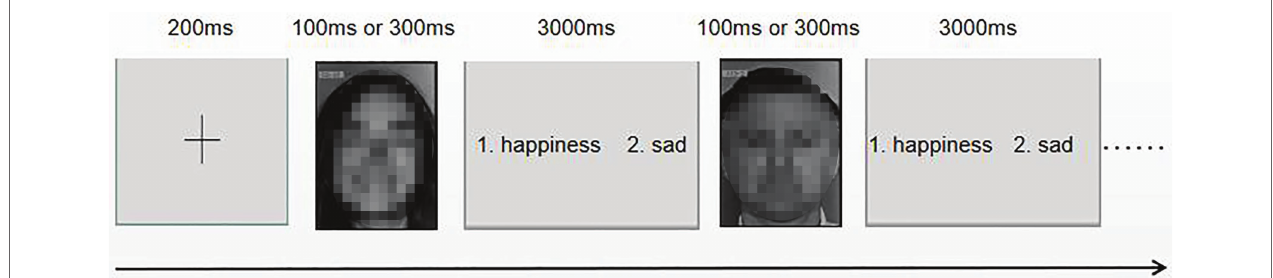
FIGURE 1 | Flowchart of facial expression